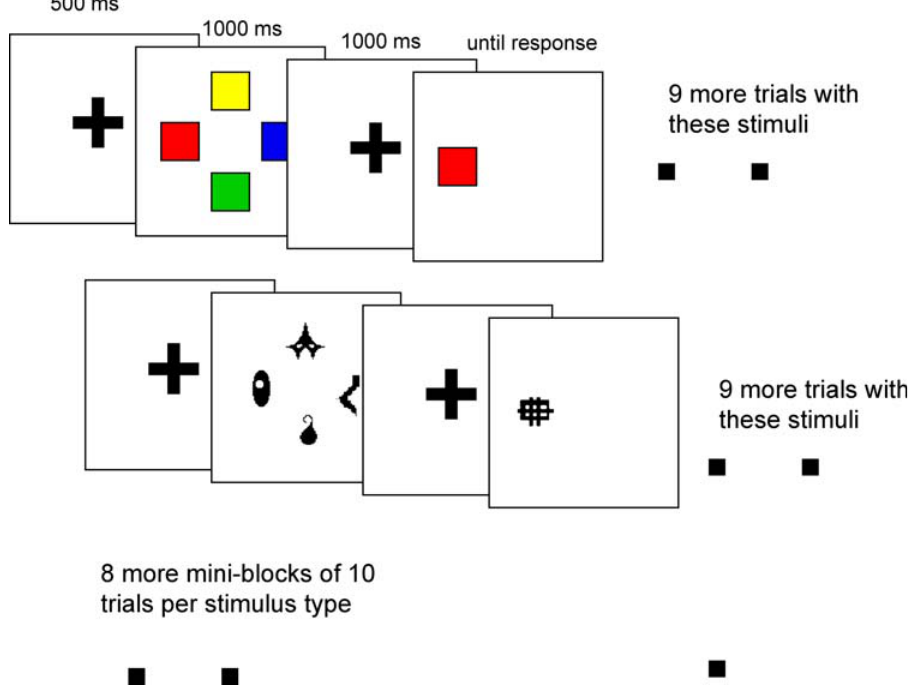
Figure 2. The design of one block of Experiment 2a. Experiment 2b was created by randomizing the trial order for 3 of the 6 blocks.